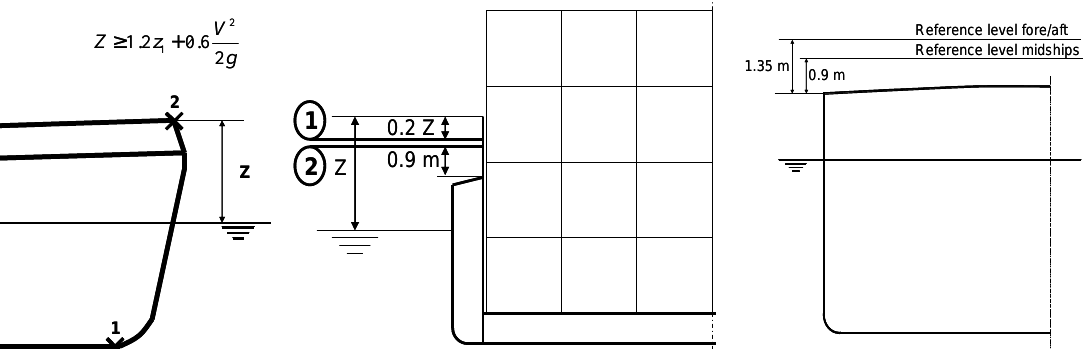
Figure 4c (left). Required height of fore deck or top of bulwark on the forecastle (z 1 = level reached once in a